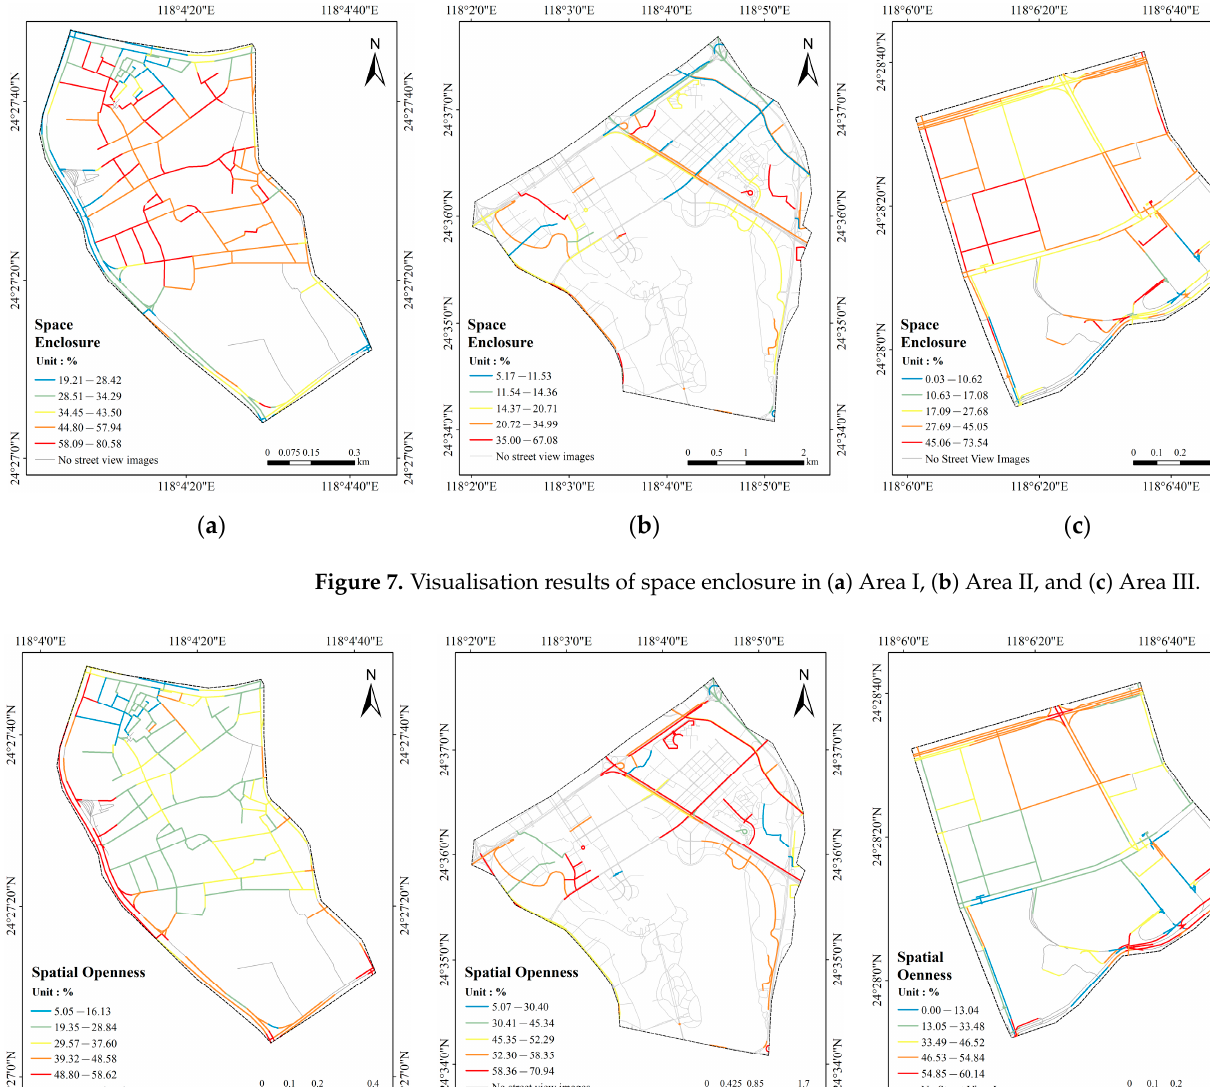
Figure 6. Visualisation results of the visible green indicator in ( a ) Area Ⅰ , ( b ) Area Ⅱ , and ( c ) Area Ⅲ .